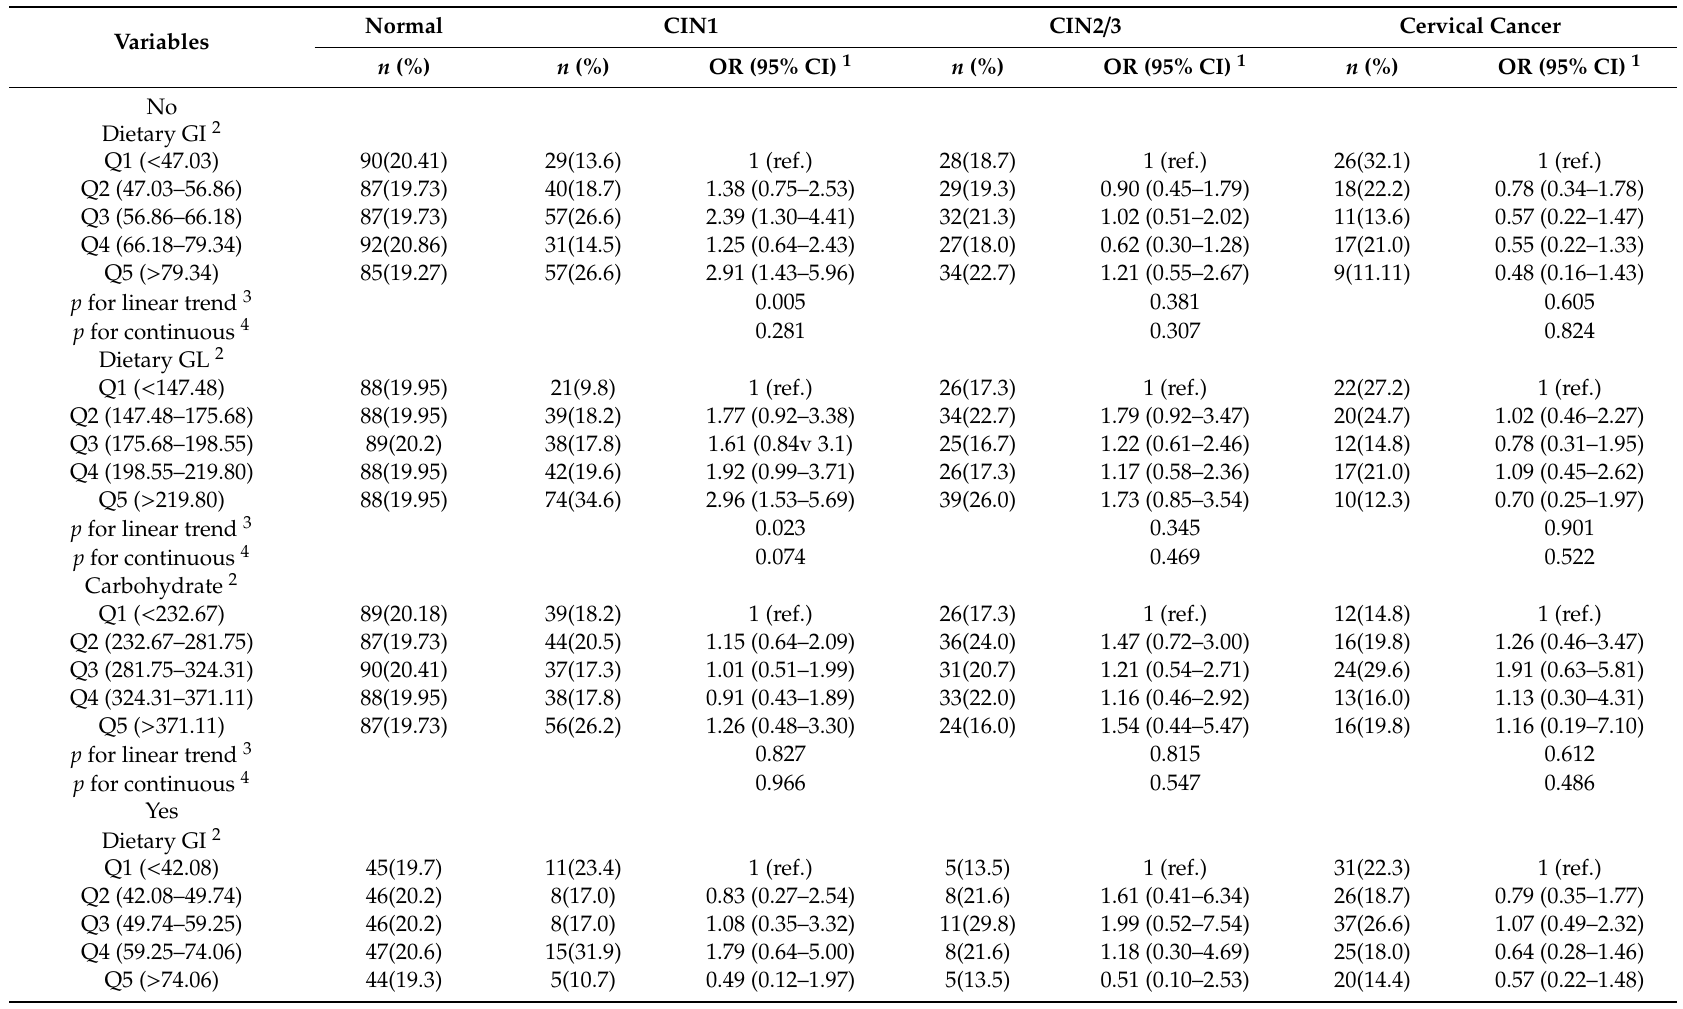
Table 4. Multivariate ORs of dietary glycemic index (GI) and glycemic load (GL) for the risk of CIN and cervical cancer stratified by menopausal